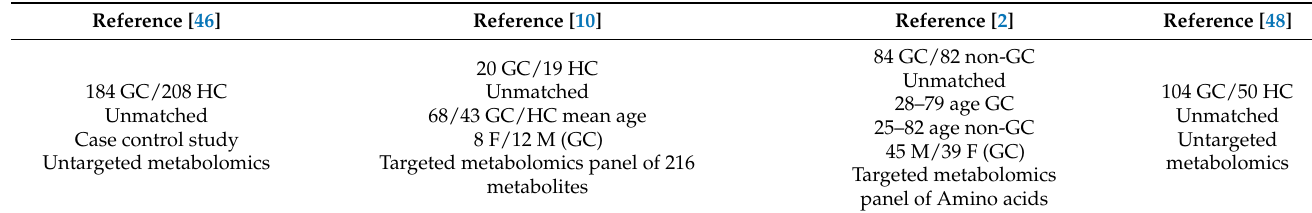
Table 1. Description of patient cohorts and study types used in GC